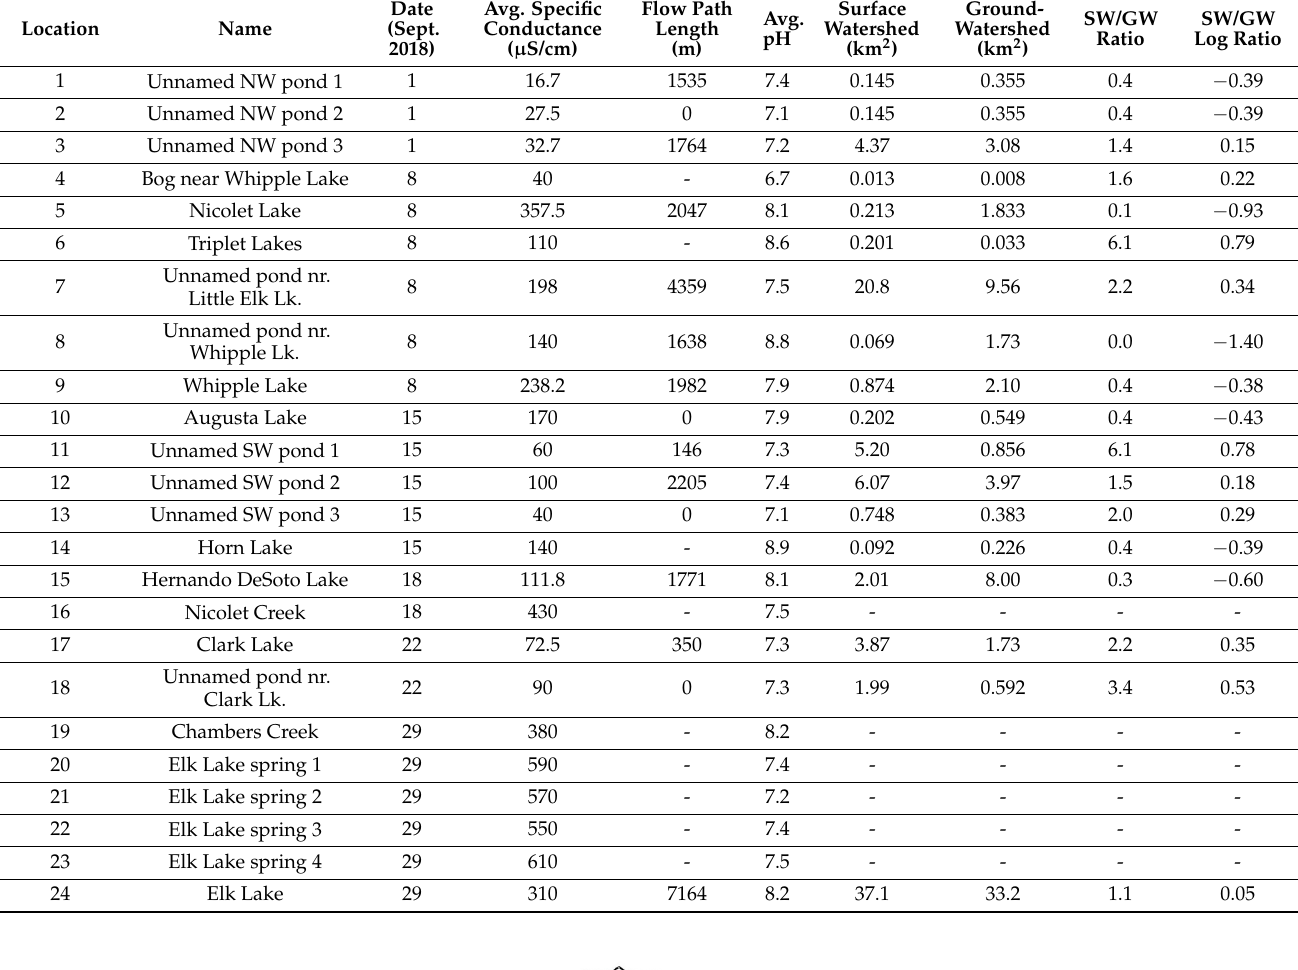
Table 1. Water quality, flow path, and watershed data for sampled lakes and ponds.